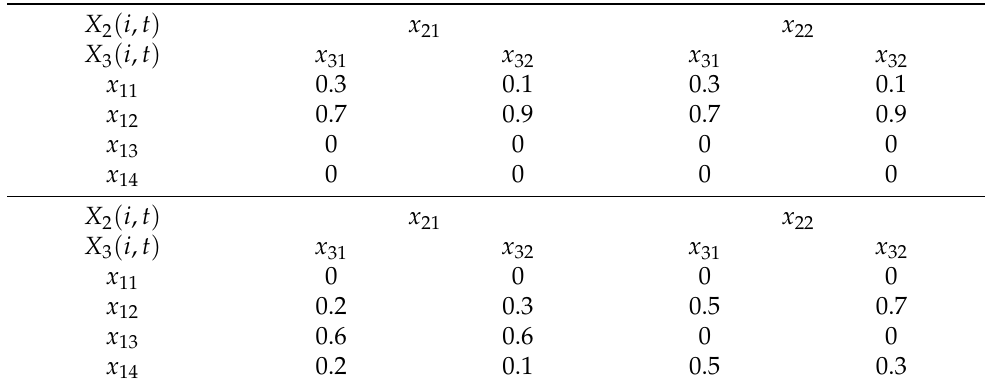
Table 12. CPDs of the future state with more than four infectious devices and with initial states: susceptible (on the left) and infectious (on the